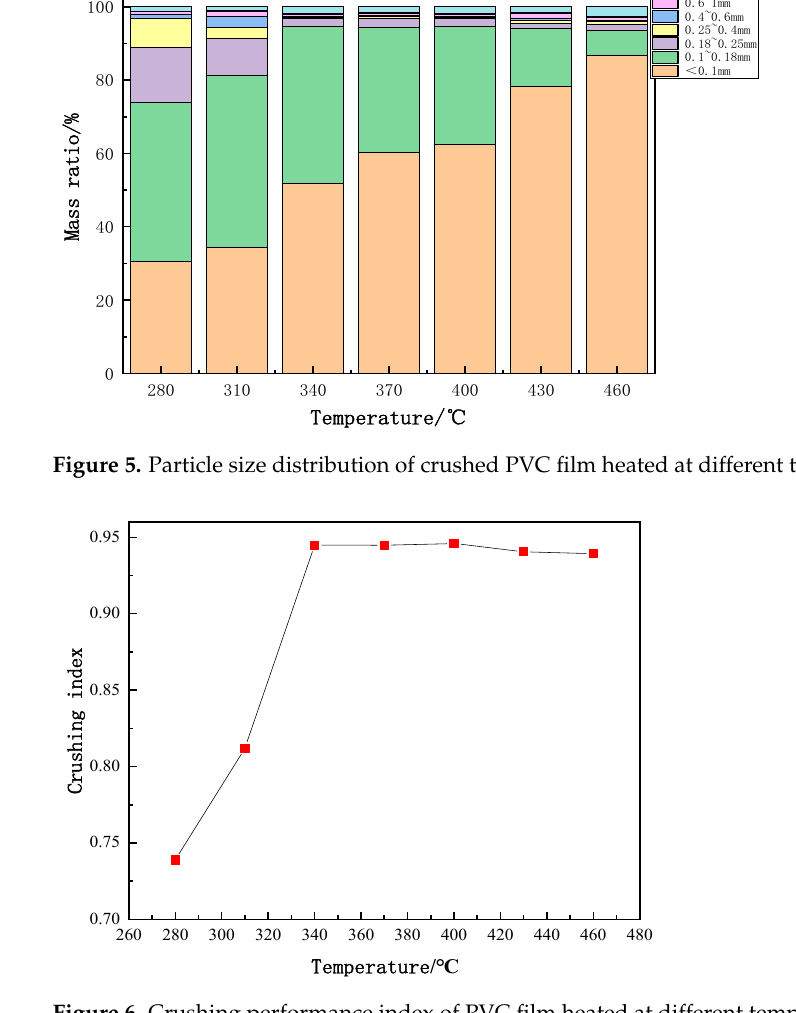
Figure 6. Crushing performance index of PVC film heated at different